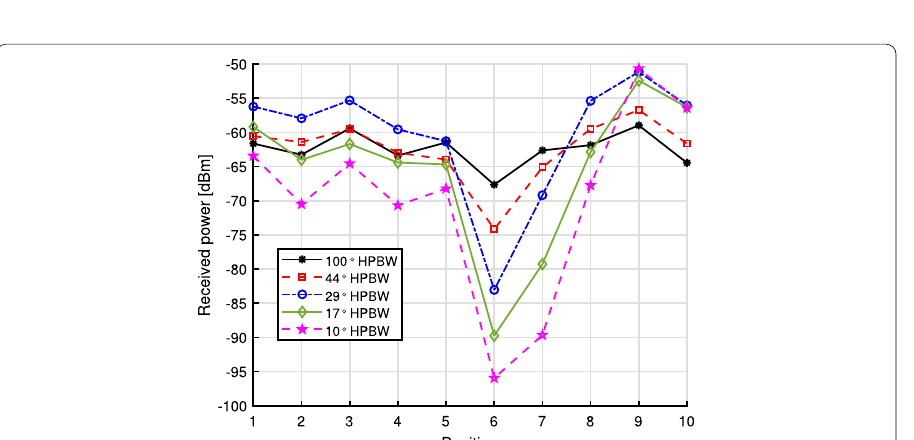
Fig. 11 Received power at receiver positions with different Tx2 antenna